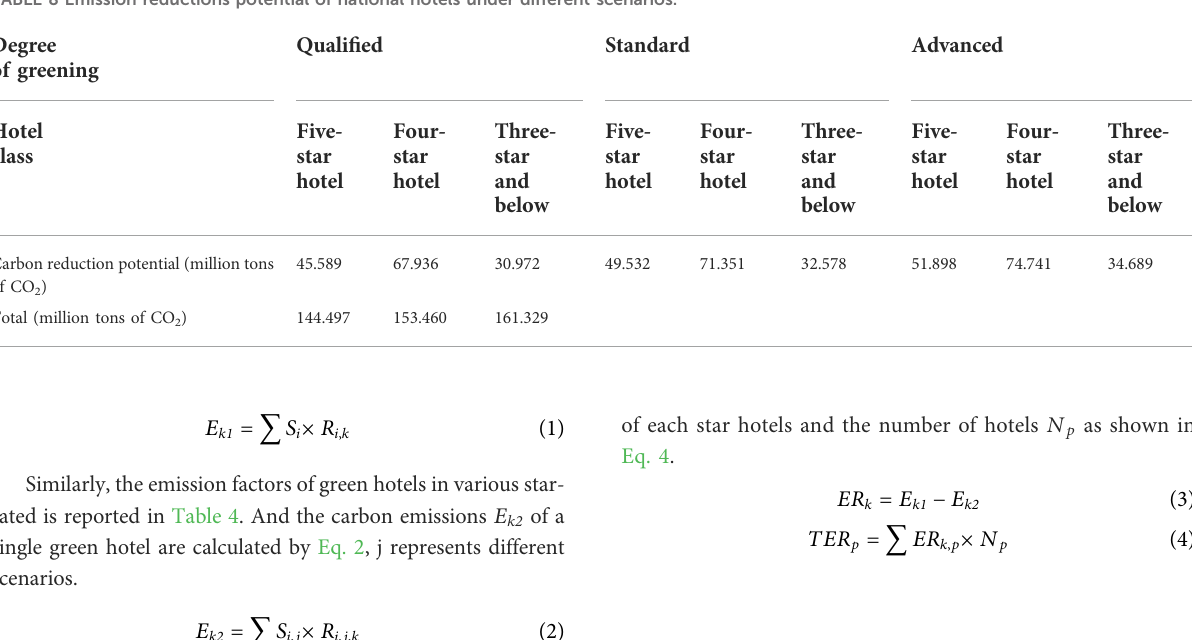
TABLE 8 Emission reductions potential of national hotels under different